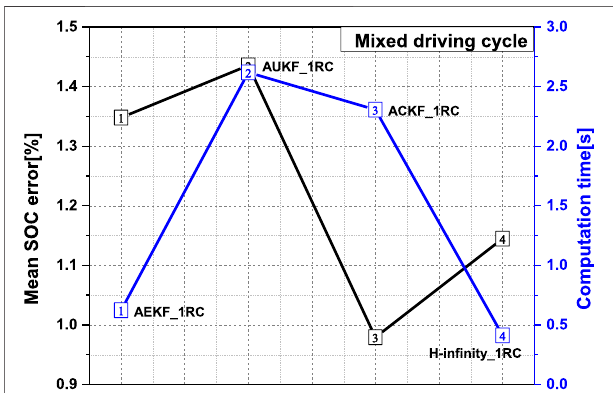
FIGURE 10 | Comparison results of the four estimators with 1% current